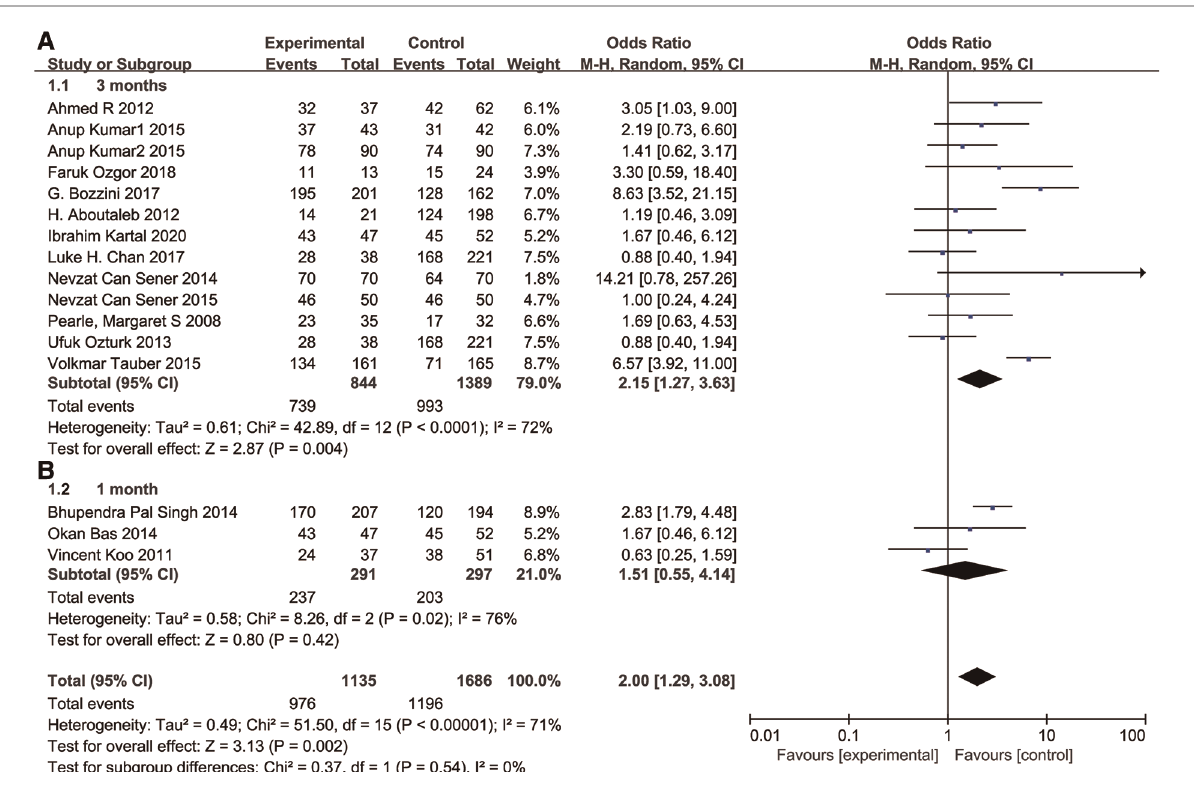
FIGURE 4 Forest plot and meta-analysis of stone-free rate for ( A ) 3 months after the surgery and ( B ) subgroups of the stone-free rate of 1 month after the